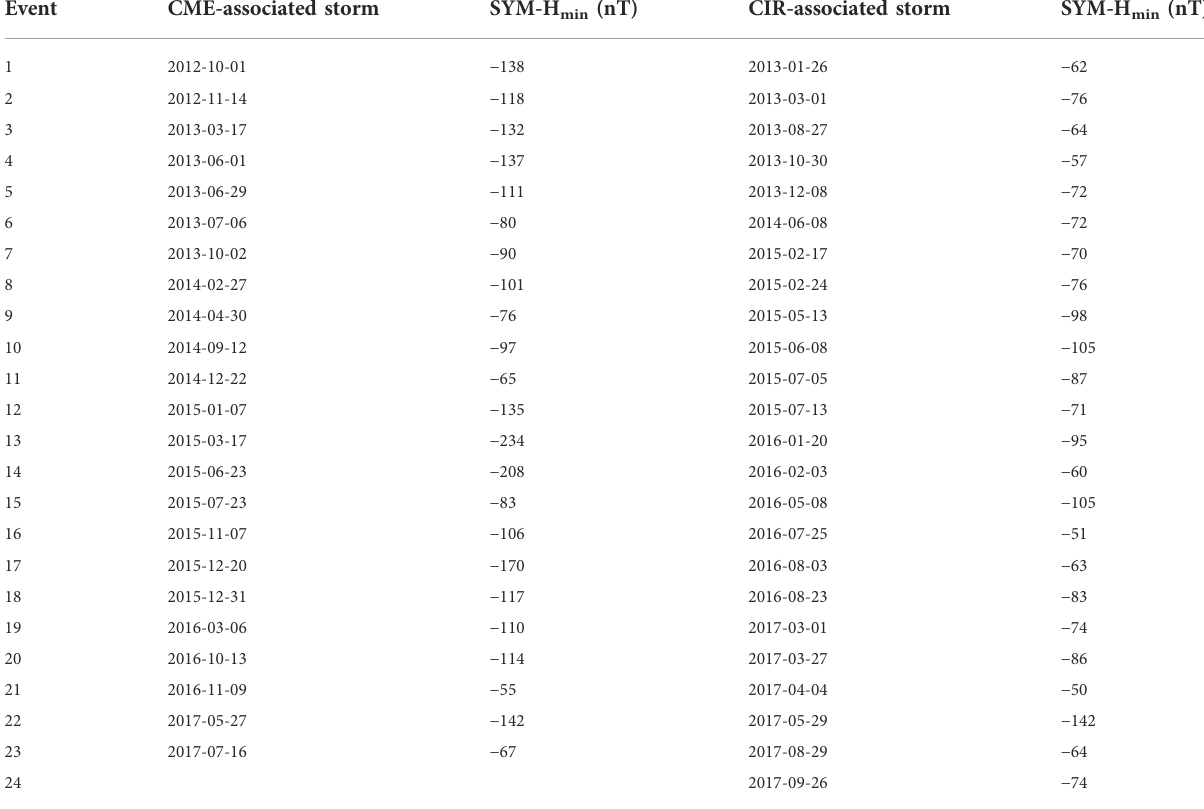
TABLE 1 List of CME- and CIR-driven geomagnetic